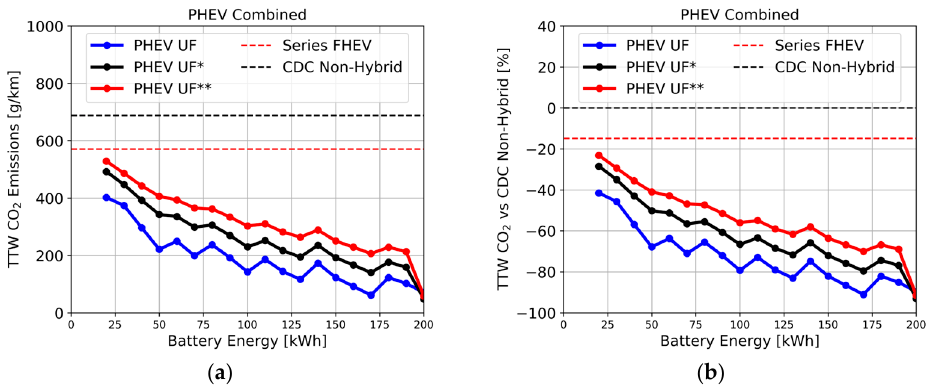
Figure 13. Total ( a ) and difference versus nonhybrid truck ( b ) in terms of tank-to-wheel CO 2 emissions under a WHVC with 50% payload. Nonhybrid and full hybrid are added for comparison.